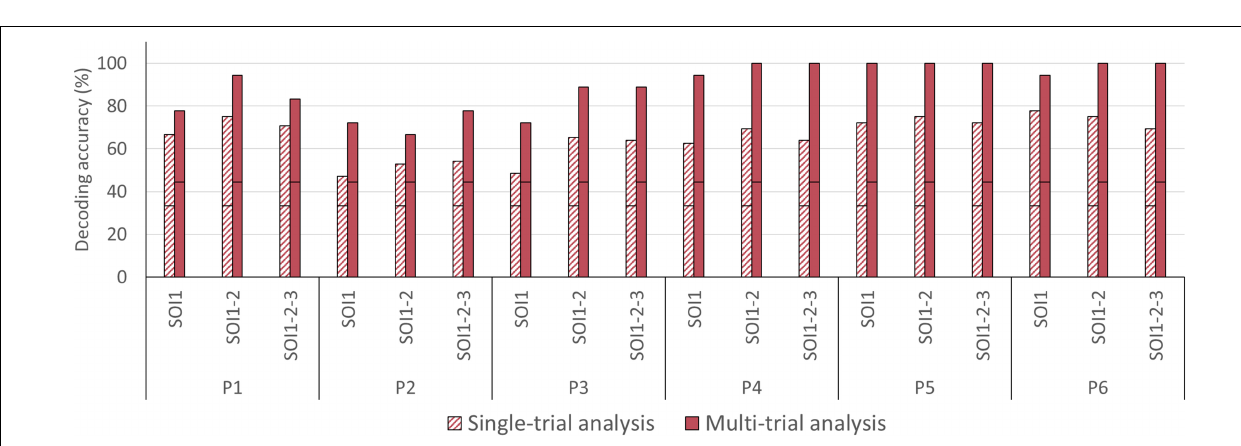
FIGURE 8 | Single- and multi-trial individual decoding accuracies across fNIRS session. Individual decoding accuracies for the 1st fNIRS session (day 1), 2nd fNIRS session (day 2), and 3rd fNIRS session (day 3) obtained with single-trial (striped bars) and multi-trial (solid bars) analysis. The black horizontal stripe within each bar graph represents the chance level for single-trial (41.67%) and multi-trial (50.00%) accuracies.